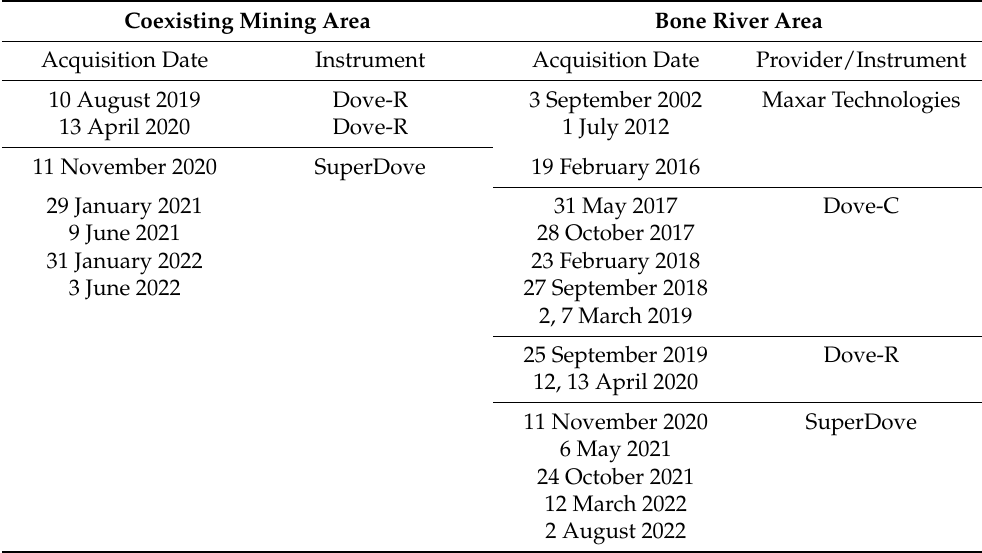
Table 1. Main specification of the imagery used in this